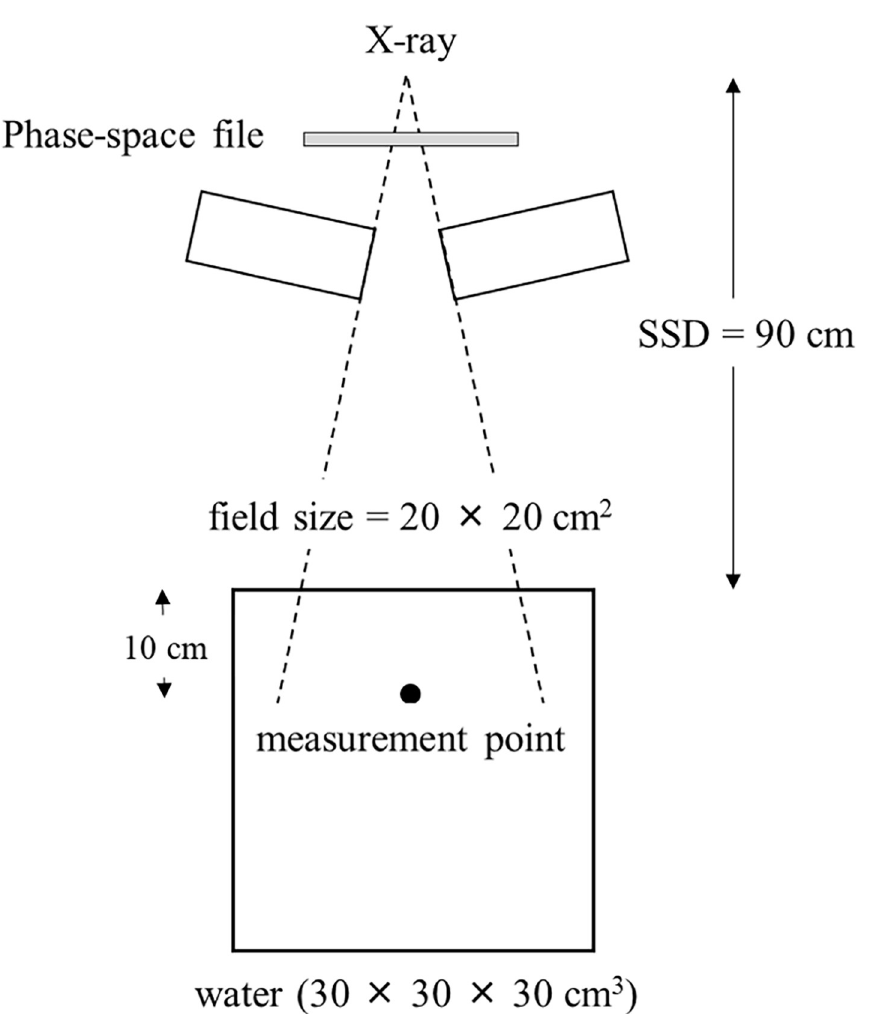
Fig 1. Irradiation geometry for the Monte Carlo calculations for both 6 MV FF and FFF beams.